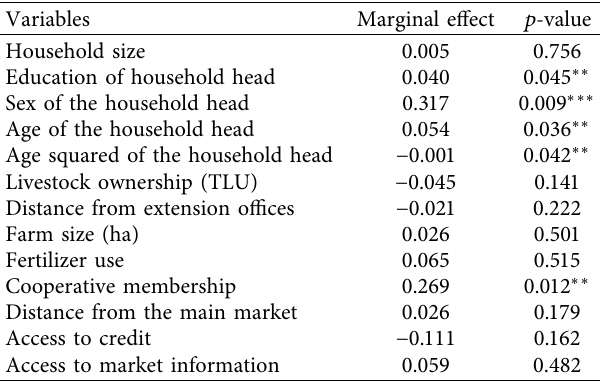
Table 2: Marginal effect estimation of the Logit